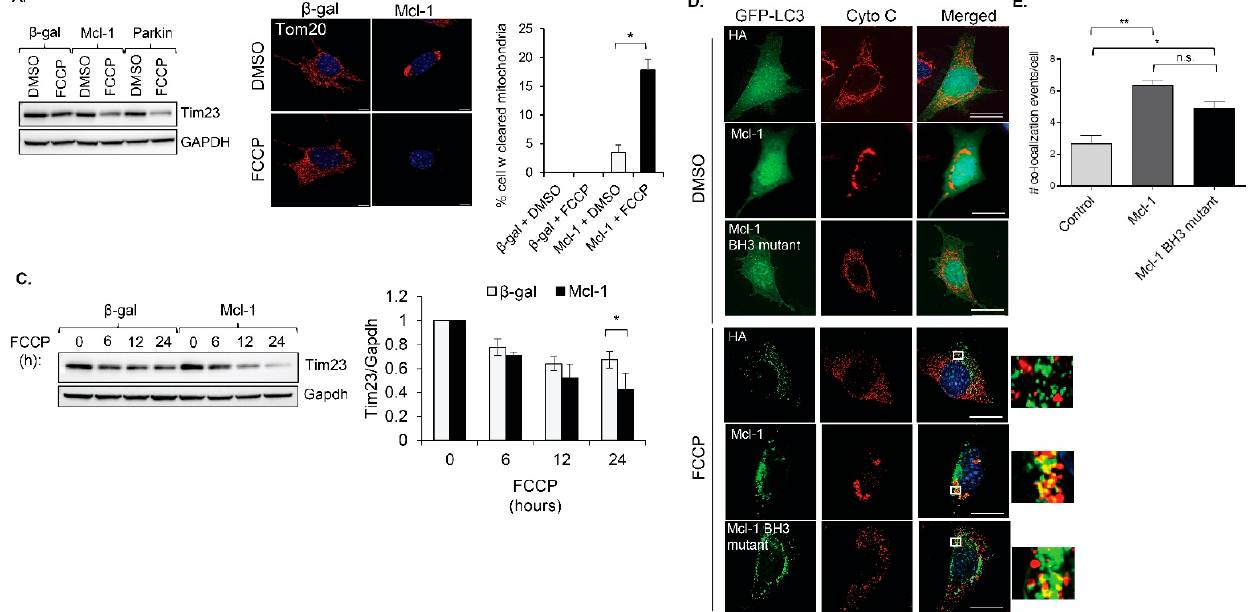
Figure 4. Mcl-1 overexpression enhances FCCP-mediated mitophagy. ( A ) Representative Western blot of Tim23 in MEFs infected with β -gal, Mcl-1 , or Parkin prior to treatment with DMSO or FCCP (25 µ M, 24 h). ( B ) Representative images of MEFs infected with β -gal or Mcl-1 . Cells were treated with DMSO or FCCP (25 µ M, 12 h), fixed, and stained with anti-Tom20. Quantification of cells with cleared mitochondria ( n = 3, 200 cells were analyzed per experiment). Scale bar = 10 µ m. ( C ) Representative blot and quantification of Tim23 protein levels in an FCCP (25 µ M) time-course experiment ( n = 3). ( D ) Representative images of GFP-LC3 and Cytochrome c in cells. ( E ) quantification of GFP-LC3 and mitochondrial colocalization events per cell ( n = 3, 18–20 cells were analyzed per